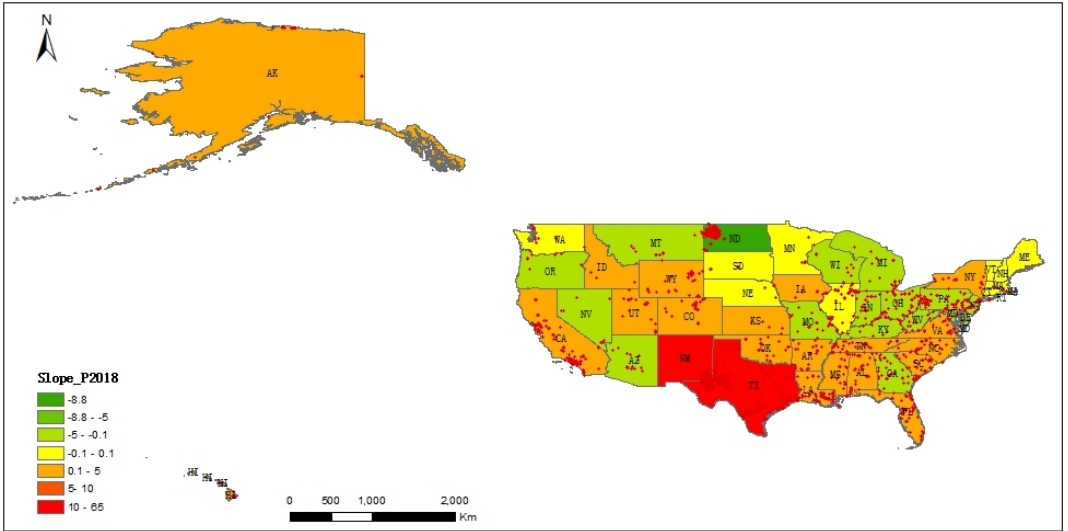
Figure 12. The comparative analysis of the distribution pattern of industrial heat releasers in 2012 and 2018 with slope index based on the number of heat